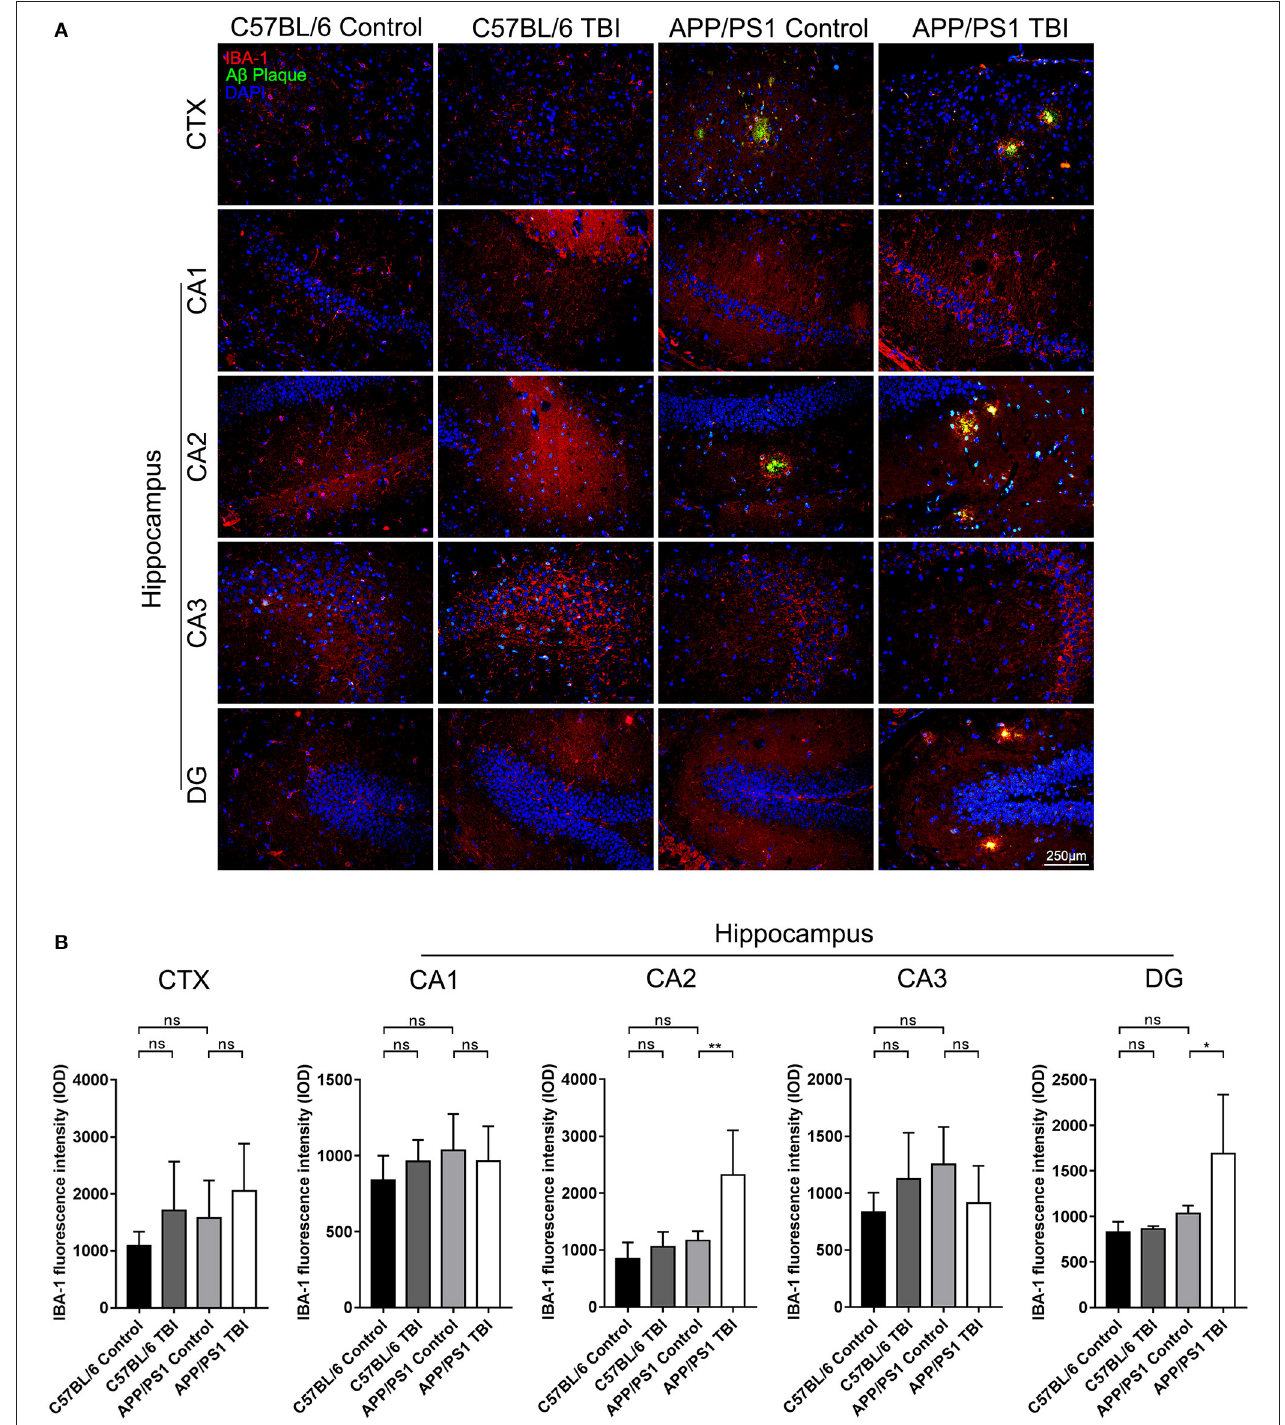
FIGURE 6 | A β plaque-related microglia-mediated neuroinflammation in the hippocampi of APP/PS1 mice was aggravated post-TBI. (A) Representative fluorescence images of cortical and hippocampal (CA1, CA2, CA3, and DG) tissues from C57BL/6, C57BL/6 TBI, APP/PS1, and APP/PS1 TBI group mice immunostained for IBA-1 (in red) and for A β plaques (in green) and subjected to nuclear staining with DAPI (in blue). (B) The fluorescence intensity of IBA-1 in the cortex and in the hippocampus (CA1, CA2, CA3, and DG). The error bars represent the SEM ( n = 8/group). ns, non-significant; * p < 0.05; ** p < 0.01.